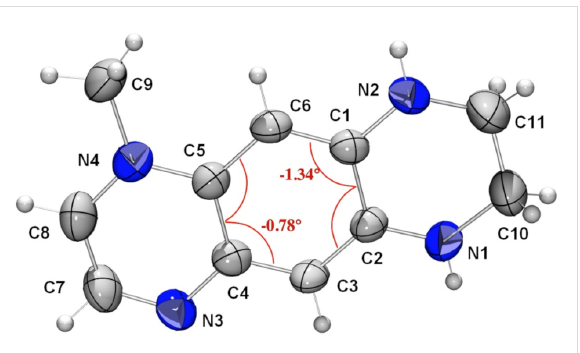
Figure 4: The ORTEP view of 7a (the iodine counter anion has been omitted for clarity). Torsion angles within the benzene ring are given in